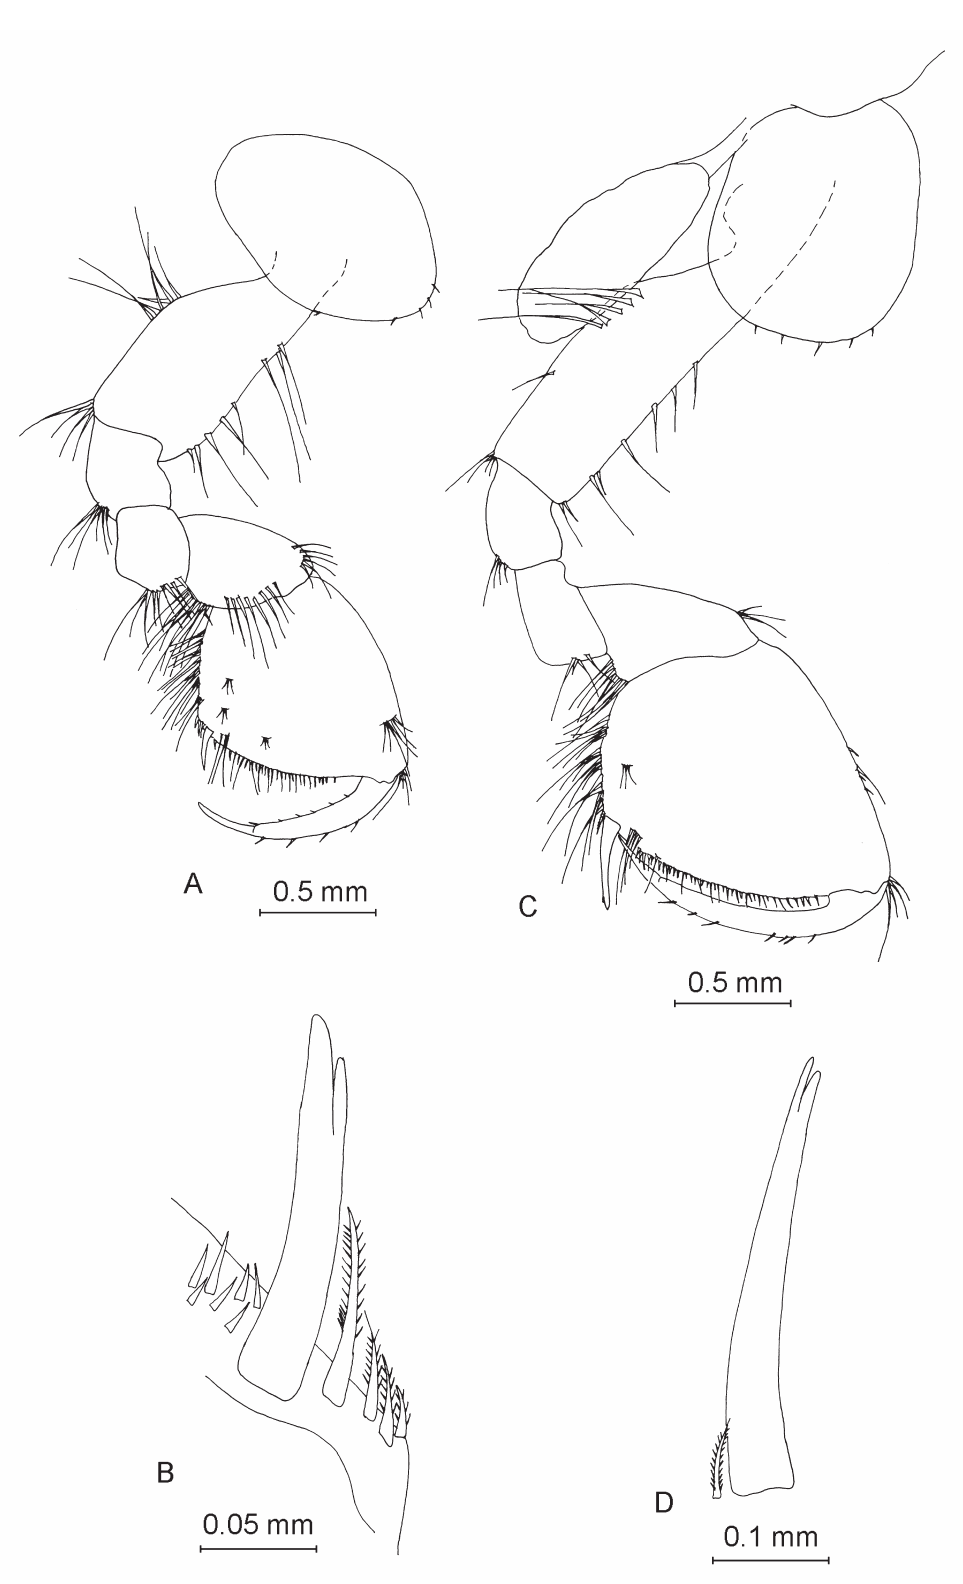
Fig. 11. ♀. A . Gnathopod I. B . Propodus teeth of gnathopod I. C . Gnathopod II. D . Propodus teeth of gnathopod